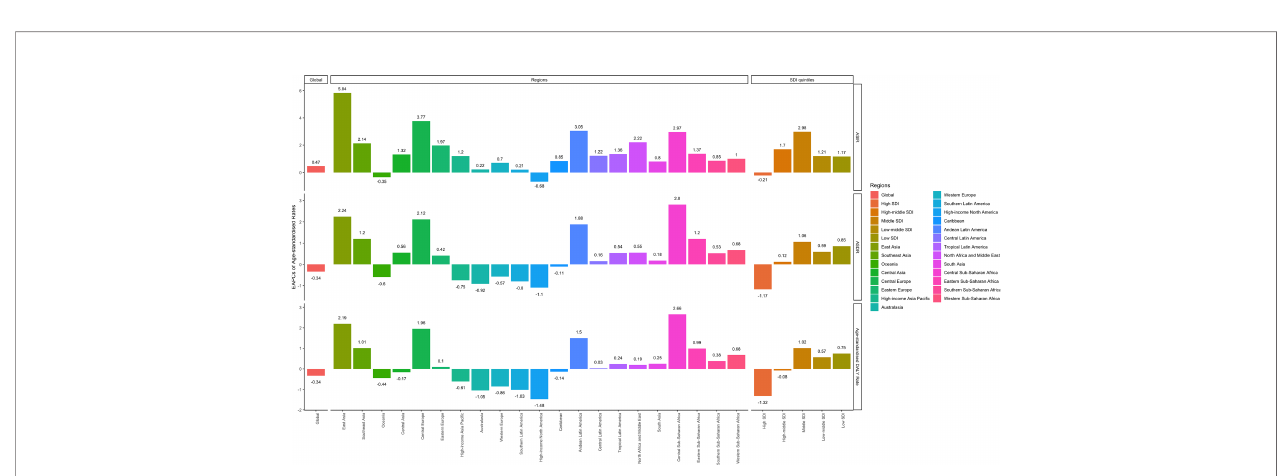
FIGURE 3 | EAPCs of ASIR (upper), ASDRs (middle), and age-standardized DALY rates (lower), in the global (left), regional (middle) and SDI (right) levels. (ASIR, age-standardized incidence rate; ASDR, age-standardized death rate; DALY, disability-adjusted life year; SDI, socio-demographic